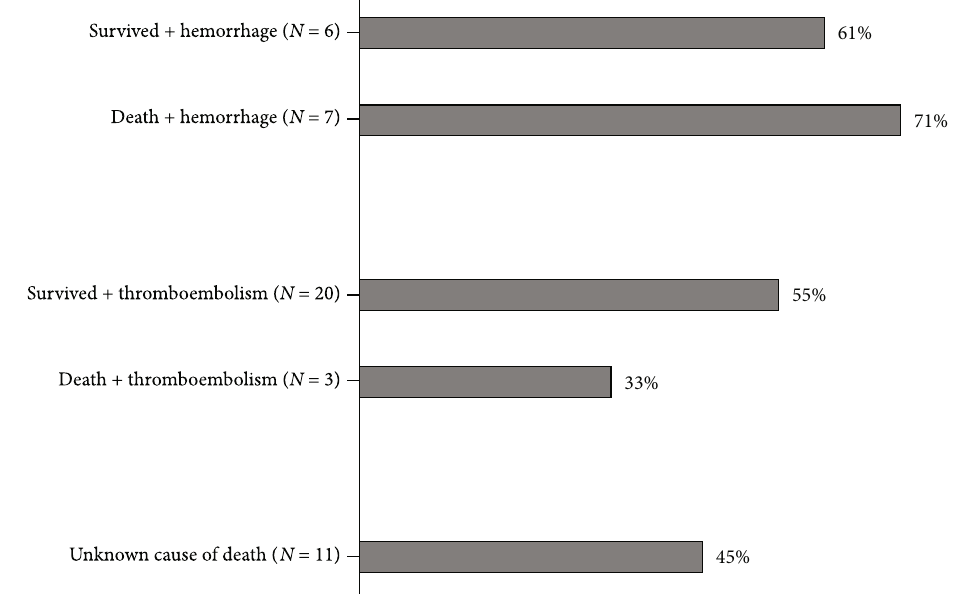
Figure 3: Proportion of patients with good/full treatment adherence among patients with complications (each category shows the number of patients in this group, and the corresponding percentage refers to the proportion of patients with good or full treatment adherence in this